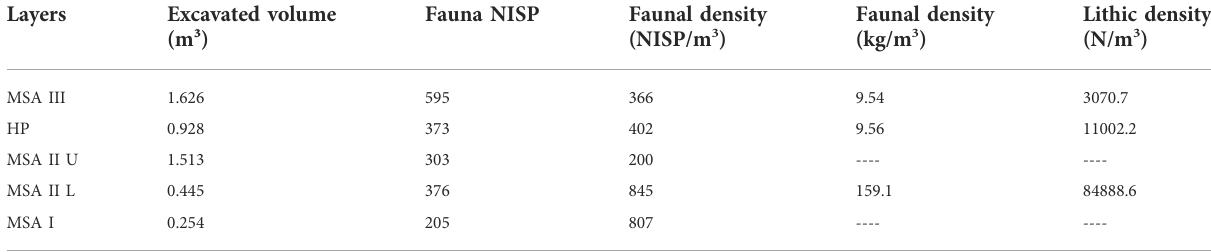
TABLE 6 Faunal and lithic density at Klasies River. Excavated volume of deposit from Thackeray (1988). Numbers of identi fi ed specimens (NISP) of faunafromVanPletzen(2000).Faunaldensitydataforweight(kg)basedondatafromLap(2020)andPearson(2021).LithicdensityforMSAIIIand HP from Wurz (2000) using Thackeray ’ s (1988) excavated volumes. Lithic density for MSA II Lower from Brenner et al. (2022). Layers